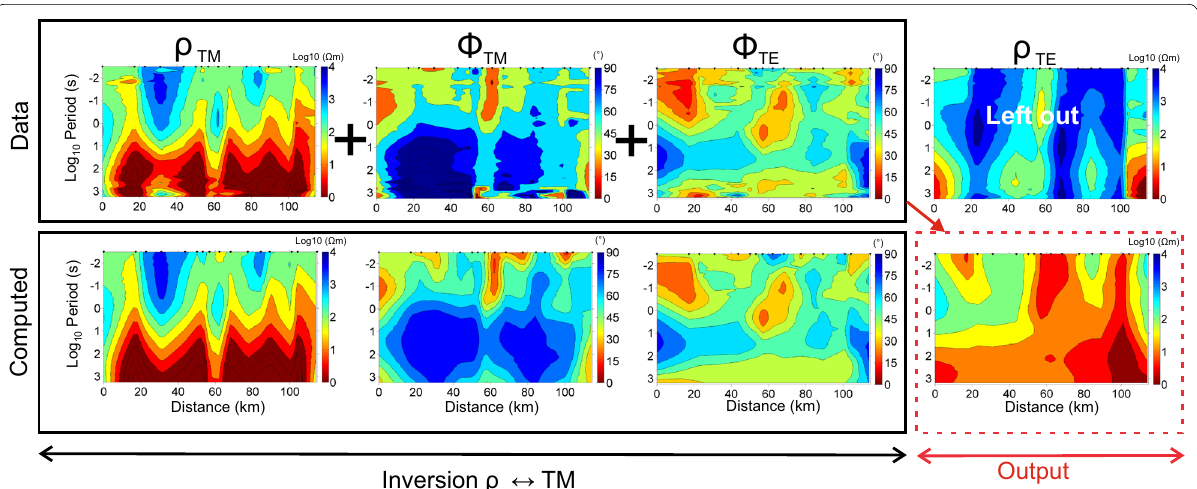
Fig. 6 Fit to the data for the invariant ρ assumed as the TM mode. The upper images are the data pseudo‑sections and the ones below are the − corresponding responses of the model. Notice that the pseudo‑sections of the TE apparent resistivity don’t look alike at all in this case, just as they don’t for the strike of 30° in Fig. 5. The other three pairs indicate a good fit to the data. The TE apparent resistivity was not part of the inversion − process